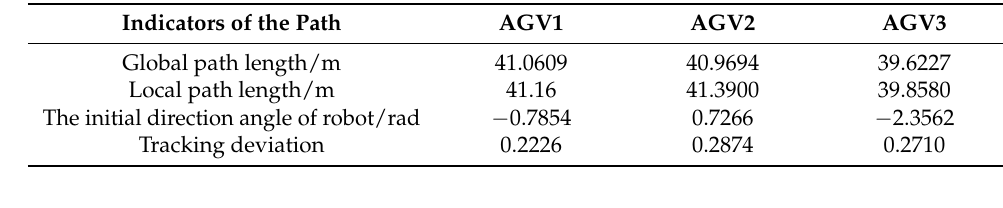
Figure 24. Multi−robot parameter comparison. ( a ) Comparison of linear velocity. ( b ) Comparison of angular velocity. ( c ) Comparison of tracking deviation.